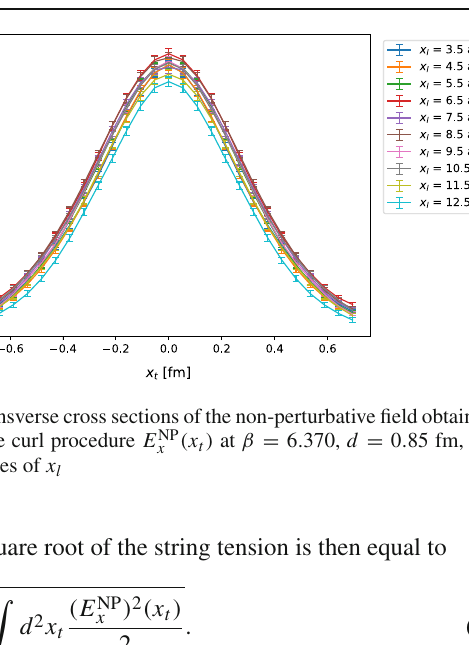
Fig. 8 The Clem fit (Eq. (9) to the non-perturbative chromoelectric field E NP x obtainedfromthecurlprocedurefor β = 6 . 240, d = 0 . 51fm, x l = 3